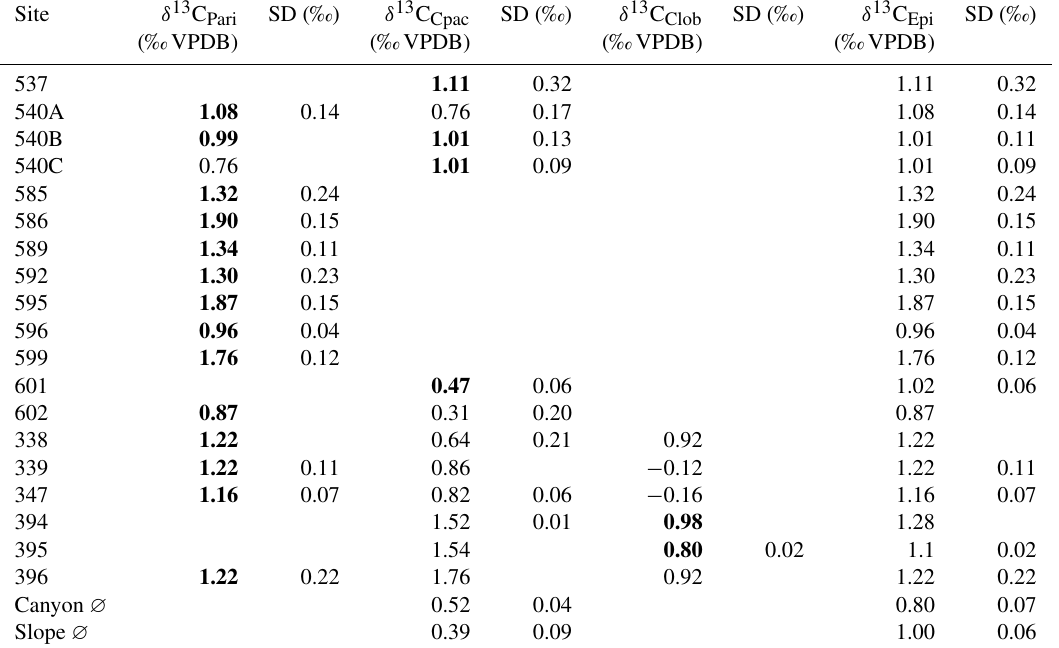
Table 2. Average stable carbon isotope composition of selected benthic foraminifera with standard deviations. Bold values of epifaunal species were applied to estimate δ 13 C Epi . Also given are values for Uvigerina mediterranea tests larger than 600µm and the difference of this species compared to the average epifaunal stable carbon isotope ratios ( (cid:49)δ 13 C Umed-Epi )